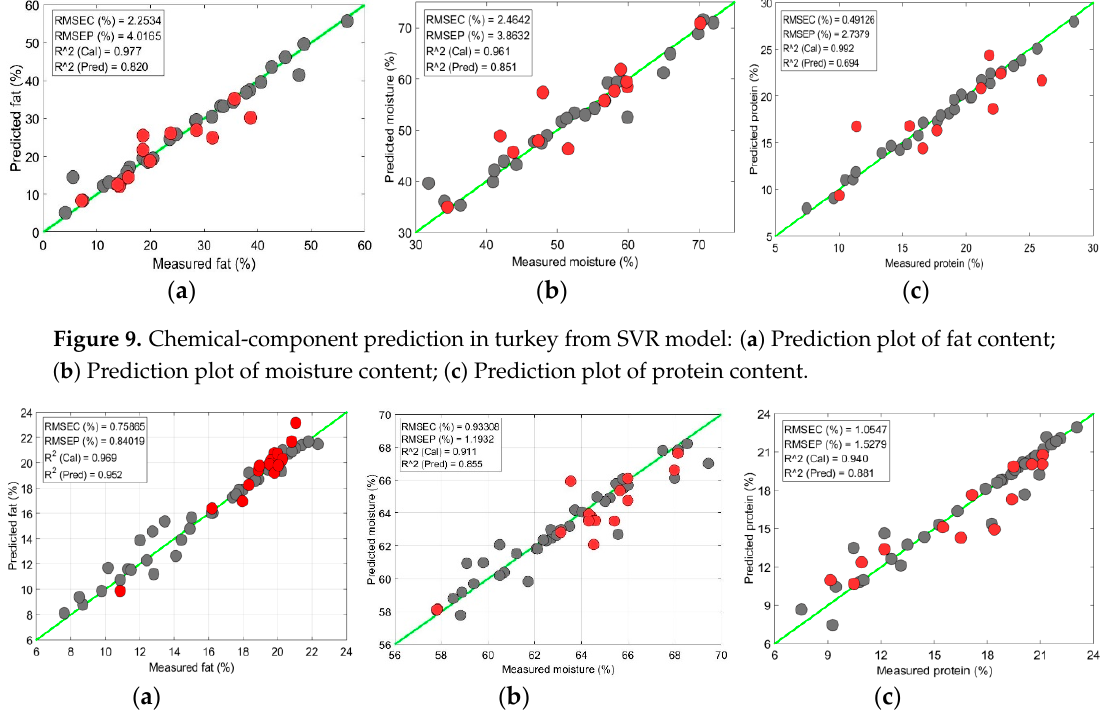
( c ) Figure 10. Chemical-component prediction in tenderloin from SVR model: ( a ) Prediction plot of fat content; ( b ) Prediction plot of moisture content; ( c ) Prediction plot of protein content. The overall chemical parameter prediction results from both analysis approaches are given in Table 2. Among all of the preprocessing methods, the SNV preprocessed data performed superior for